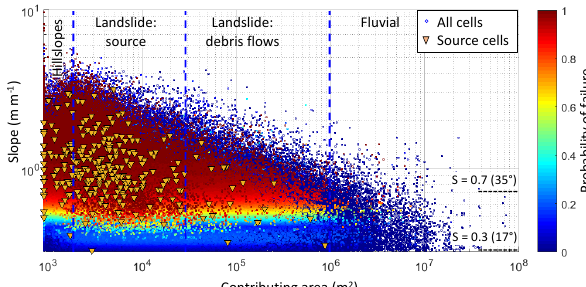
Figure 12. S –CA plot colored by the P ( F ) simulated with from the M-SD LT. Source cells (orange triangles) are the single highest- elevation grid cell within mapped debris avalanches. This figure is comparable to Fig. 5. High probabilities plot over low probabilities.